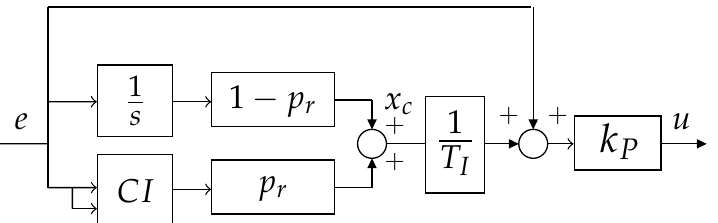
Figure 2. Block diagram of a proportional–integral plus Clegg integrator (PI + CI)